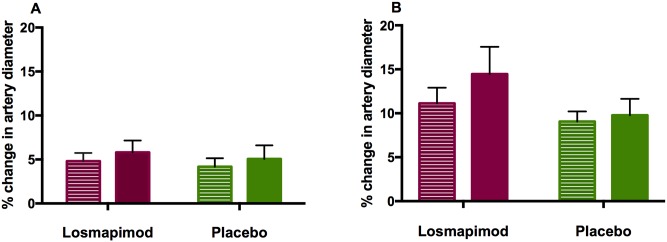
A) Percentage change in brachial artery diameter due to flow-mediated dilatation (FMD). B) Percentage change in brachial artery diameter following GTN administration, at baseline and 16 weeks treatment with losmapimod or placebo. Losmapimod had no significant effect on FMD compared to placebo, p = 0·70, although there was significant change (p = 0·03) following GTN administration. Lined bars = baseline, solid bars at 16 weeks. Bars = mean values, error bars = 95% CI.